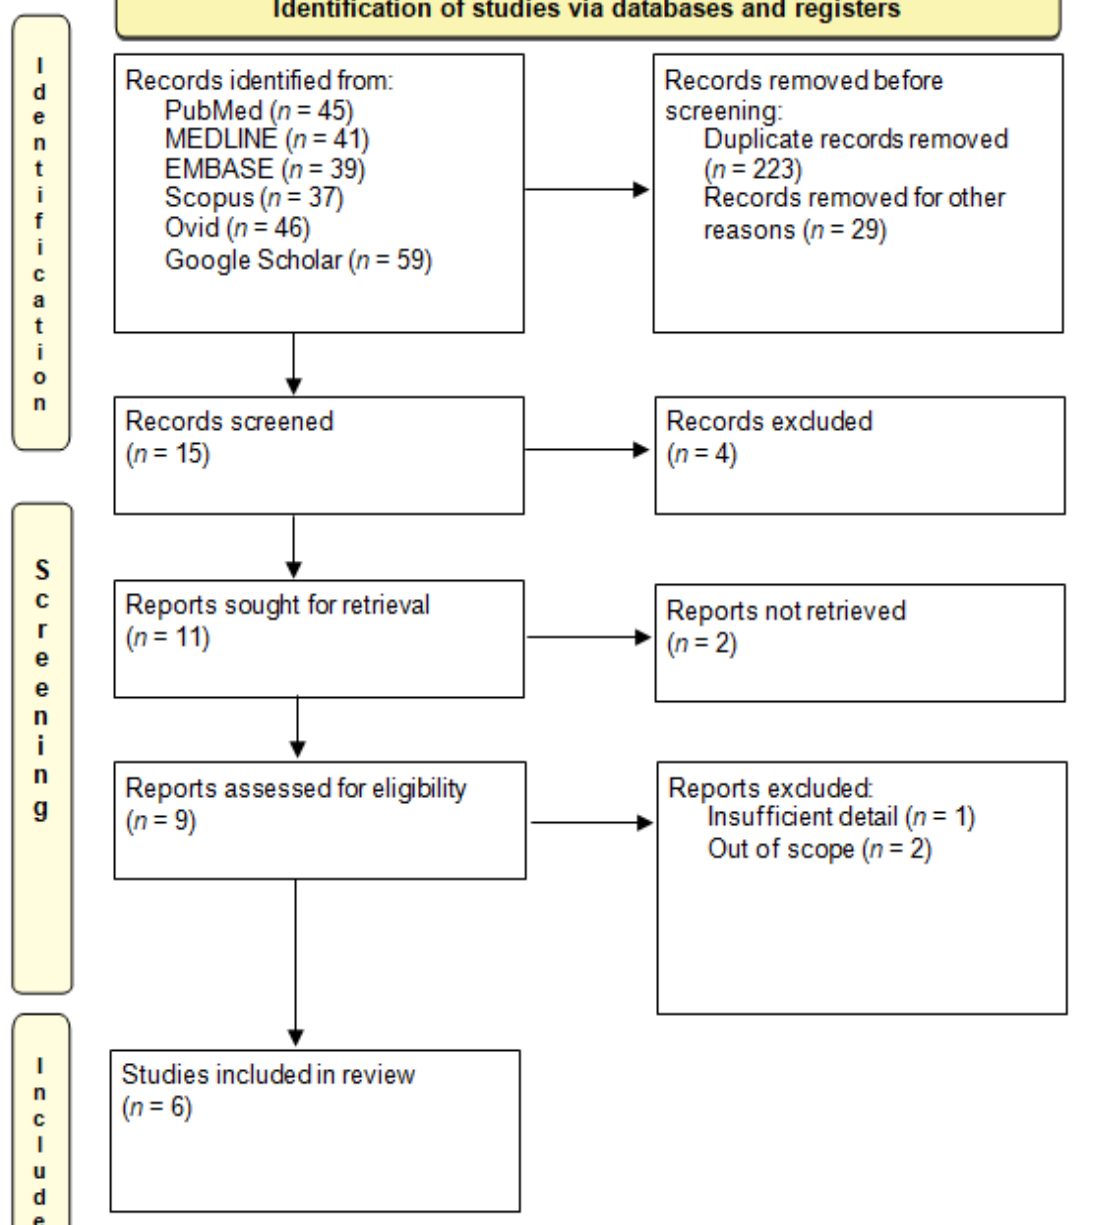
Figure 1. The Preferred Reporting Items for Systematic Reviews and Meta-analyses (PRISMA) 2020: flow chart illustrating the number of studies at each stage of the review.